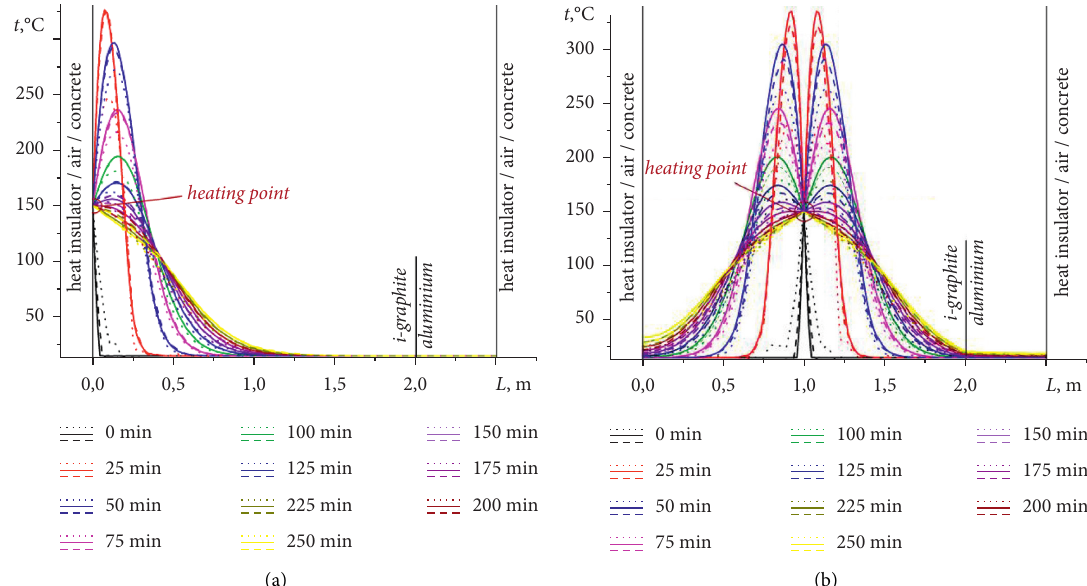
Figure 11: Dynamics of temperature fields in the irradiated graphite-aluminum system during heating in planes A (a) and B (b). Solid line: a heat insulator located on the border of the region (adiabatic conditions); broken line: concrete located on the border of the region; dotted line: air at the border of the